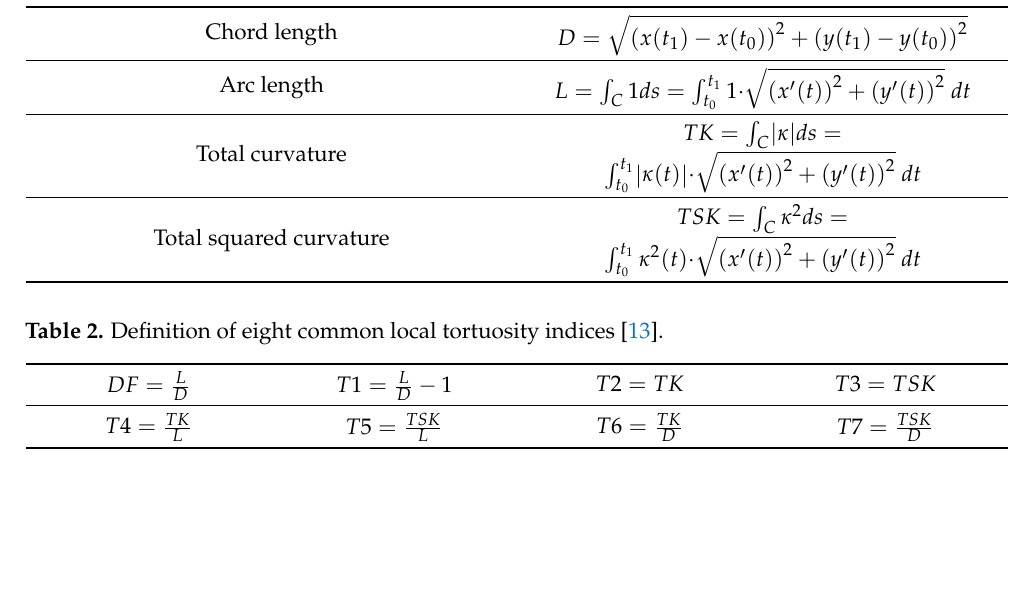
Table 1. Geometric parameters of a curve parametrized by C ( t ) .